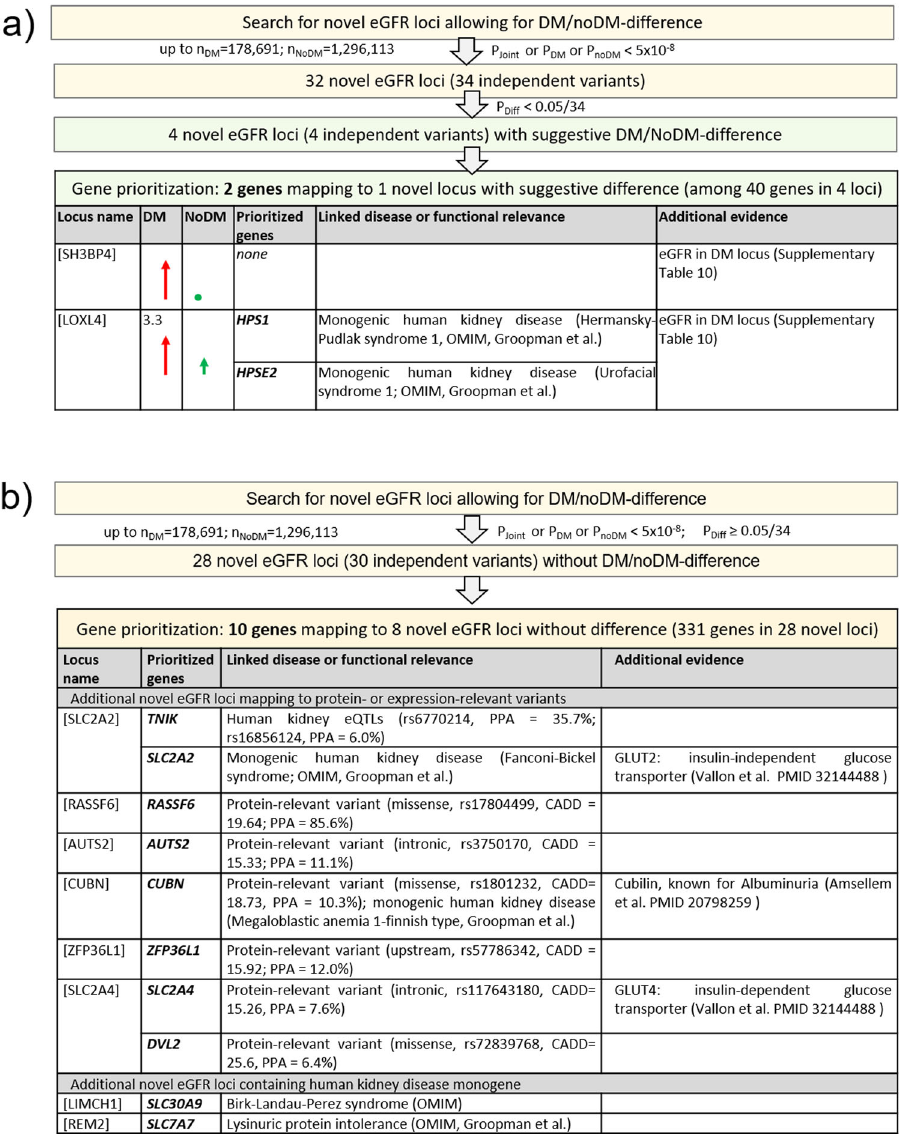
Fig. 7 Gene prioritization highlights 12 genes at novel eGFR loci. Shown are gene prioritization results for the 32 novel eGFR loci (Table 2, Supplementary Fig. 9): a for the four novel eGFR loci with suggestive difference, and b for the 28 other novel eGFR loci. We highlighted 12 genes based on association- driving variants (PPA > 5%) that were deleteriously protein-relevant or expression-modulating or genes that were known as human kidney monogenes (OMIM or ref. 78 with subsequent manual